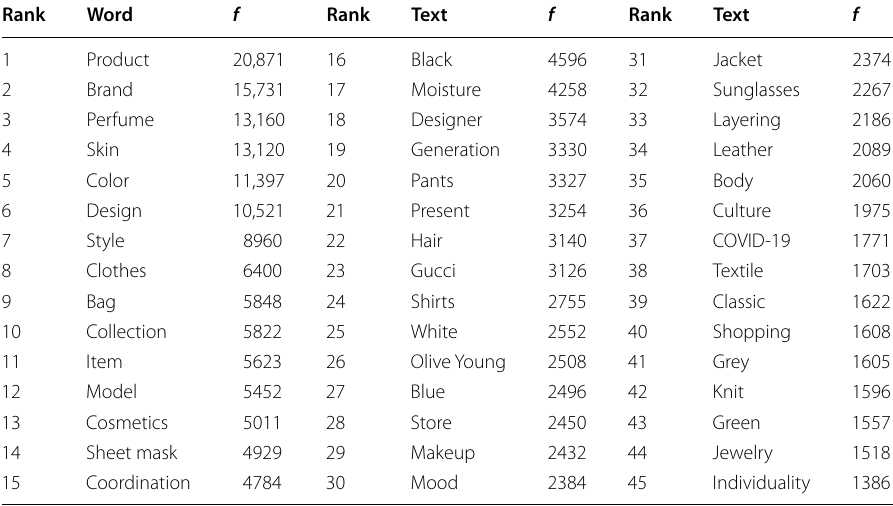
Table 1 Results of the word frequency analysis (n